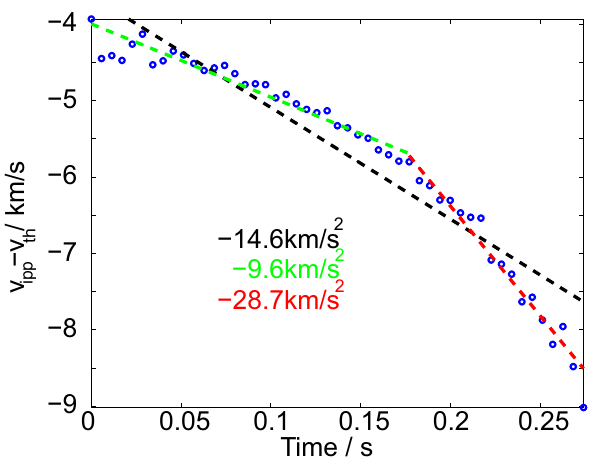
Fig. 5. Deceleration of the meteor-head echo; v IPP is the velocity calculated due to phase differences of different pulses; subtracted is the theoretical velocity change ( v th ) due to the geometrical contri- bution (geometrical acceleration: − 11.96kms − 2 ); green line: fit at the beginning of the event (0–0.18s); red line: fit at the end of the event; black line: fit of the whole event.